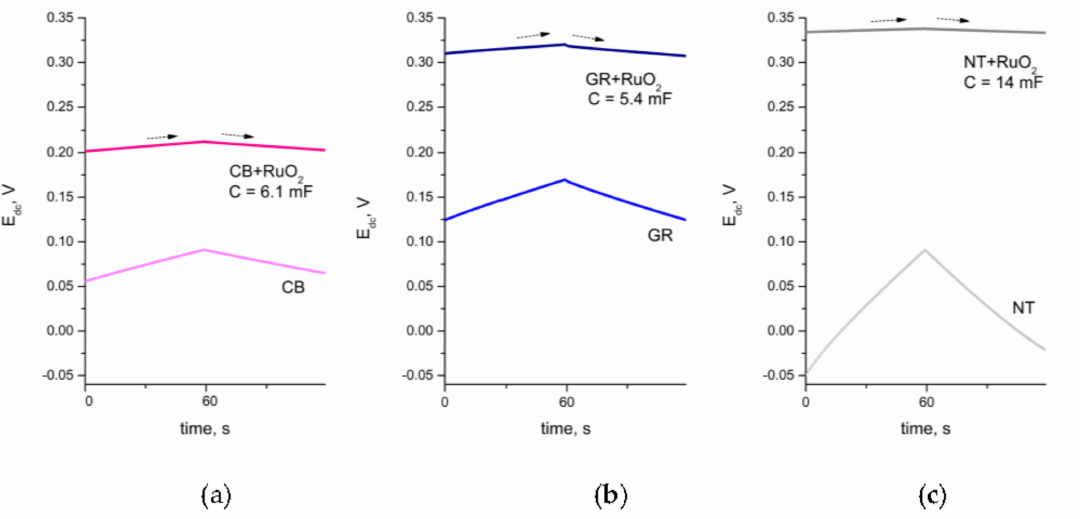
Figure 5. Chronopotentiograms of ( a ) CB-based, ( b ) GR-based, and ( c ) NT-based layers with (top curves) and without (bottom curves) the presence of ruthenium